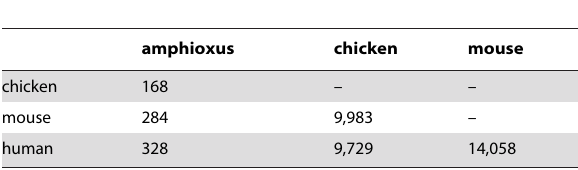
Table 1. The number of genes used in the